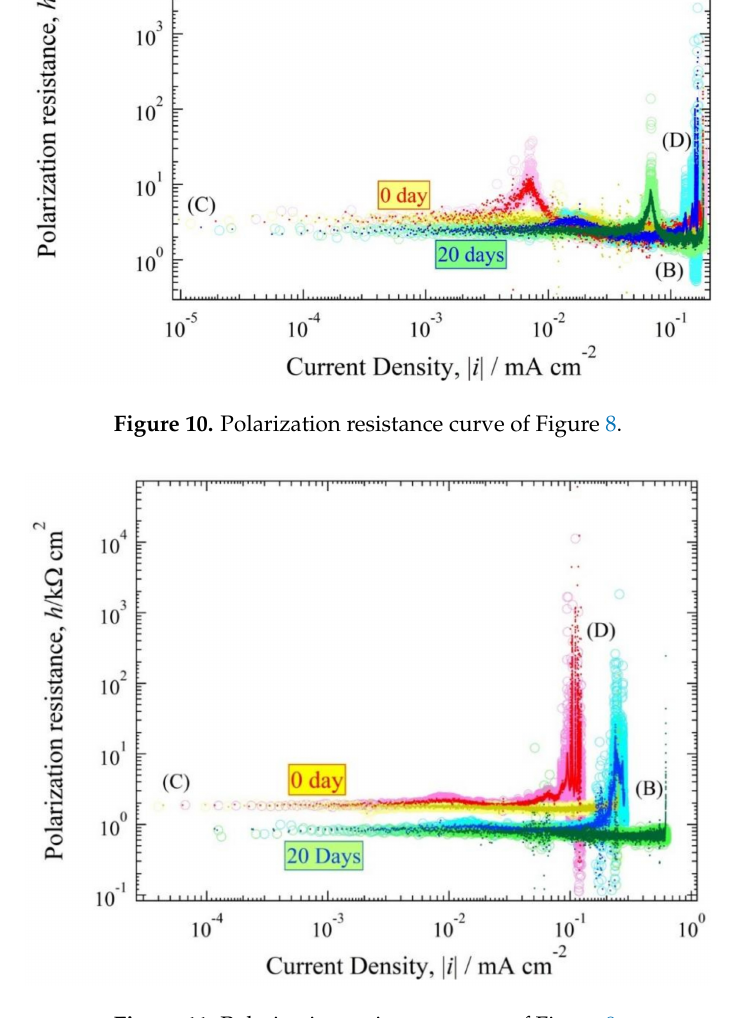
Figure 11. Polarization resistance curve of Figure